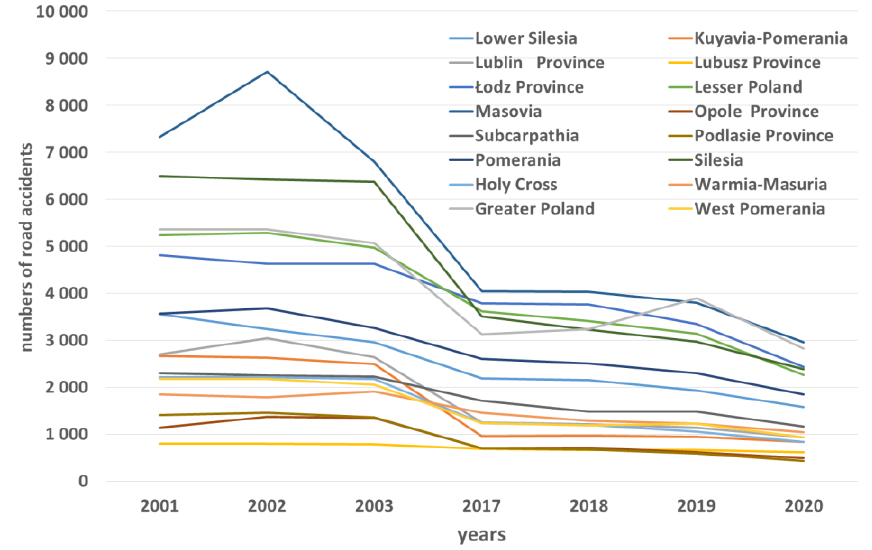
Figure 4. Number of road accidents in Poland by province from 2001 to 2021 [60].